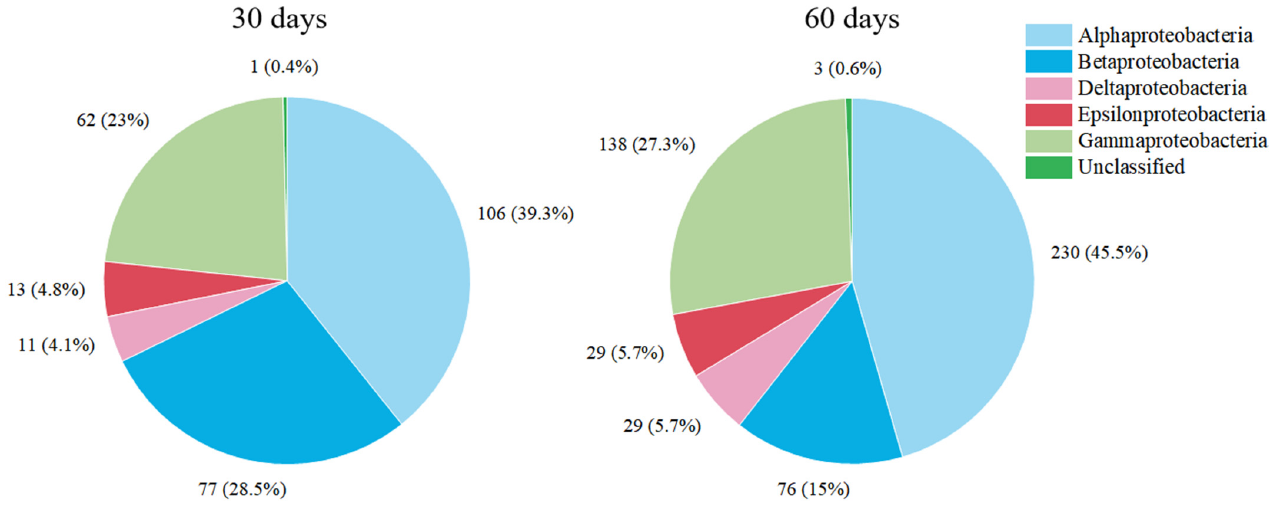
Figure 4. Relative abundance of Proteobacteria (class level) in the MBfRs with operation times of 30 days and 60 days.